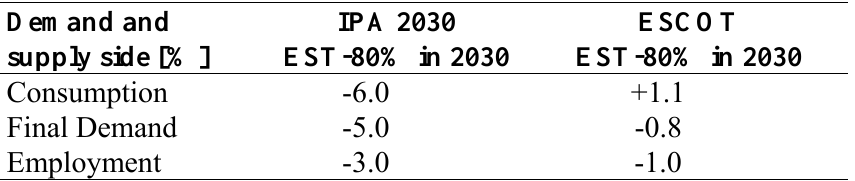
Table 5. Comparison of Final Demand for IPA and